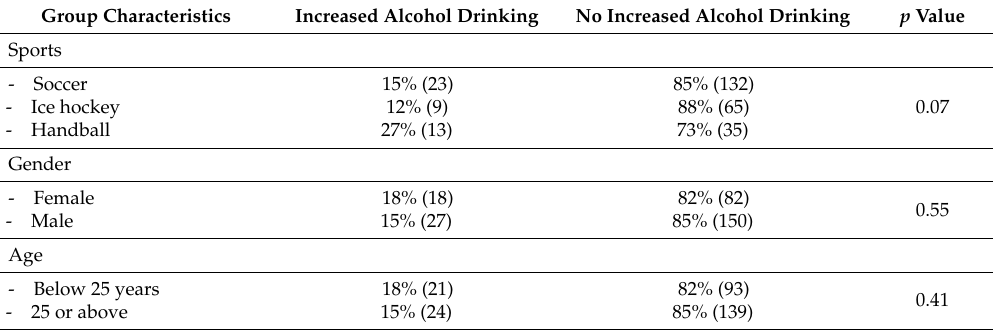
Table 6. Self-reported increase in alcohol consumption during the COVID-19 pandemic, depending on other variables. Chi-squared analyses for group